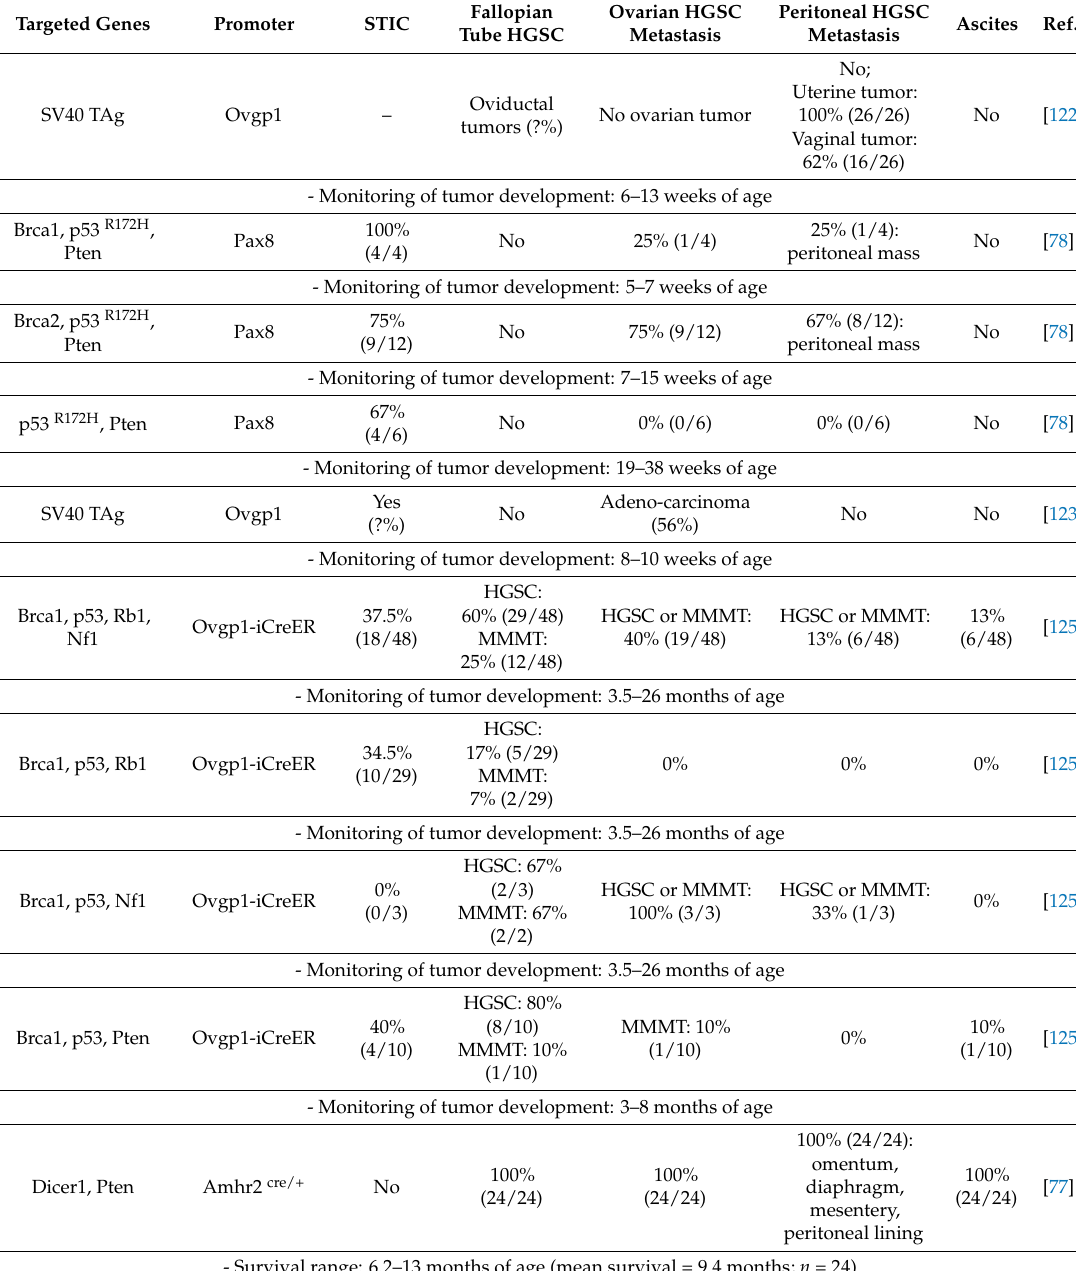
Table 2. Mouse models of ovarian cancer: fallopian tube